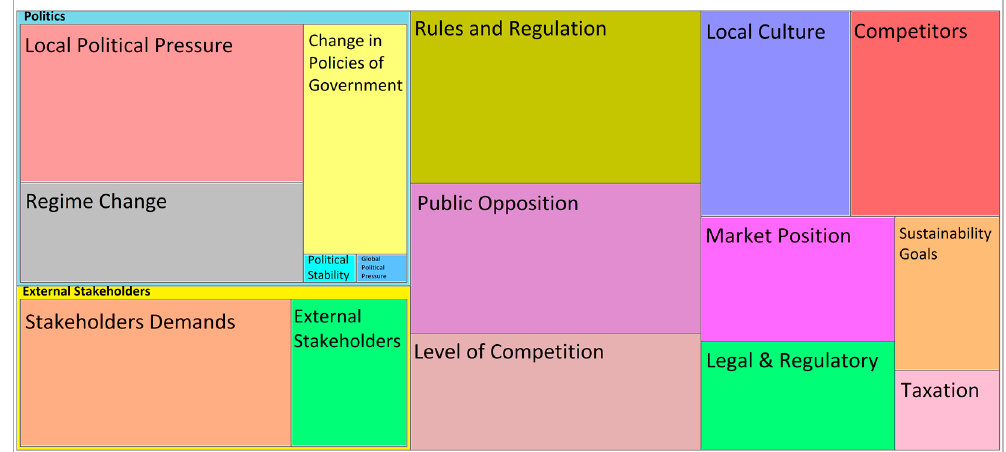
Figure 10. Hierarchy chart of environmental factors.